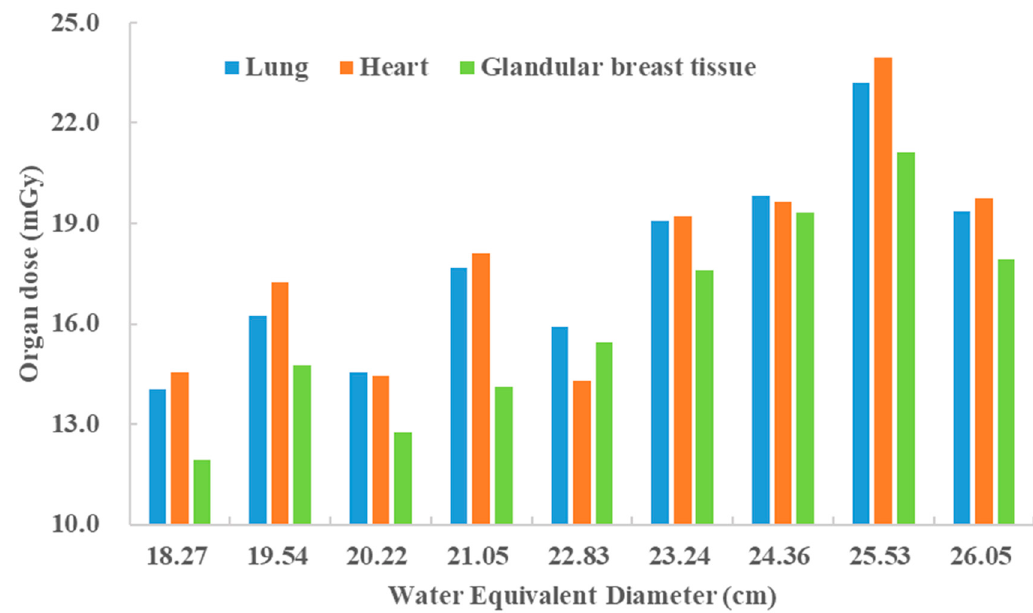
Figure 2. Organ doses simulated by Monte Carlo methods as a function of WED for female.